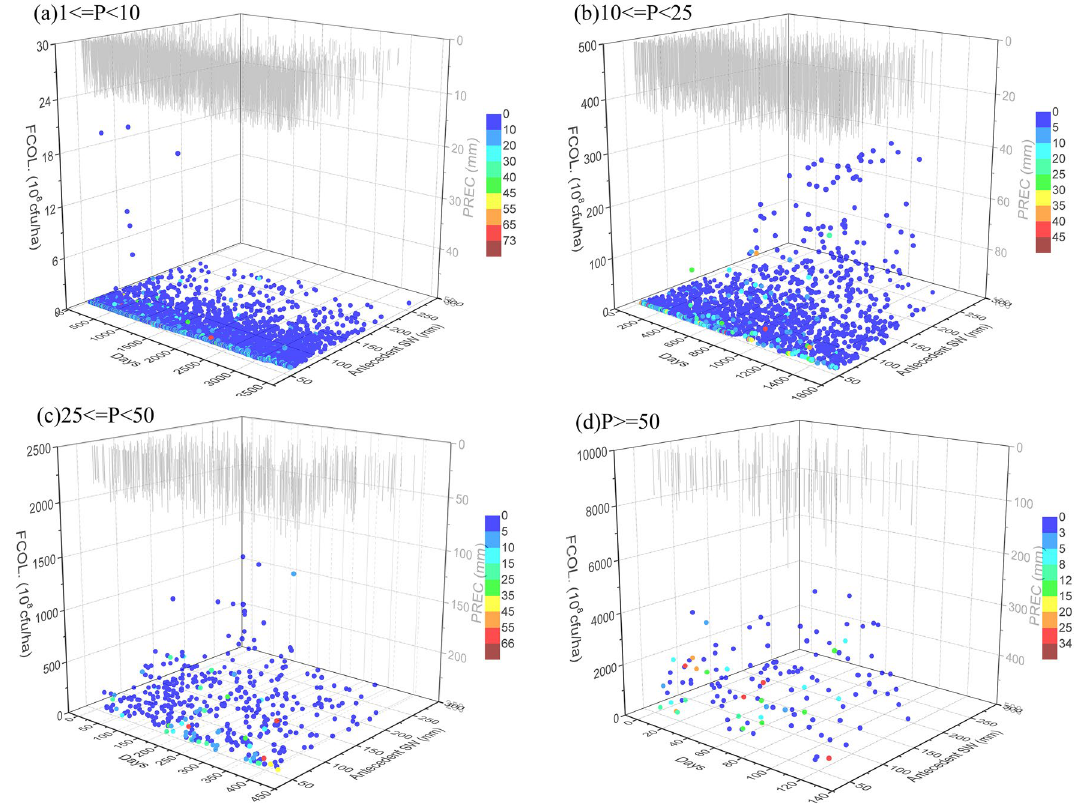
Figure 11. Relationship of fecal coliforms with precipitation (PREC, mm), antecedent drought days, and antecedent soil water (antecedent SW, mm) at different precipitation amounts: ( a ) light rain (1 ≤ P < 10 mm), ( b ) moderate rain (10 ≤ P < 25 mm), ( c ) heavy rain (25 ≤ P < 50 mm), and ( d ) rainstorm (P ≥ 50 mm). Graphs were created using OriginPro software version 9.0 (https:// www. origi nlab.